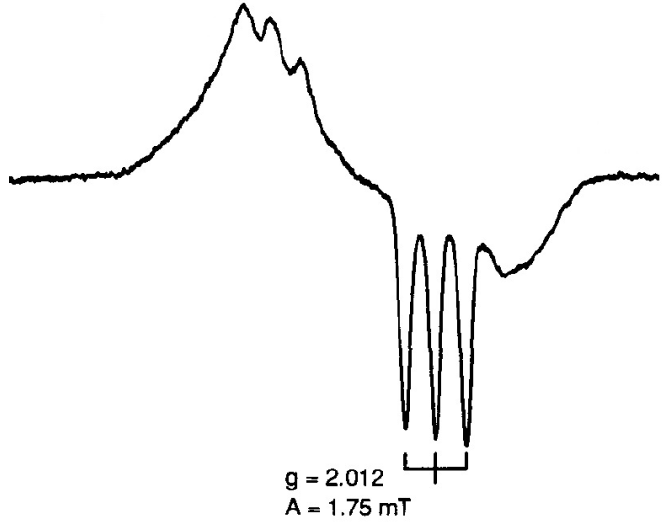
Figure 4. ESR spectrum of an adduct of 2 NO and hemoglobin at 90 K. Adapted from ref. [18]; see for details ref. [18].